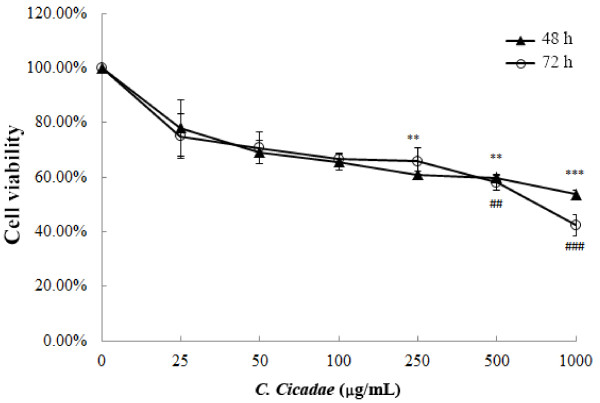
The effects of C. cicadae on MHCC97H cell viability. The cell viability was tested by MTT assay. Data were expressed as mean ± SD (n = 3 separate experiments). **,***, P < 0.01, 0.001 vs. control in 48 h treatment group, and ##, ###, P < 0.01, 0.001 vs. control in 72 h treatment group, respectively.